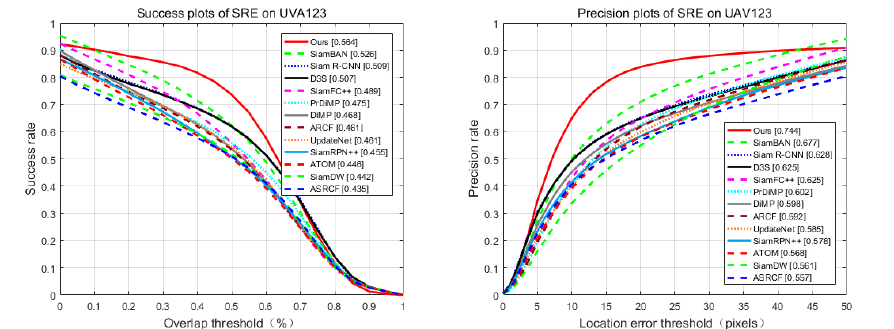
Figure 9. Success and precision plots on